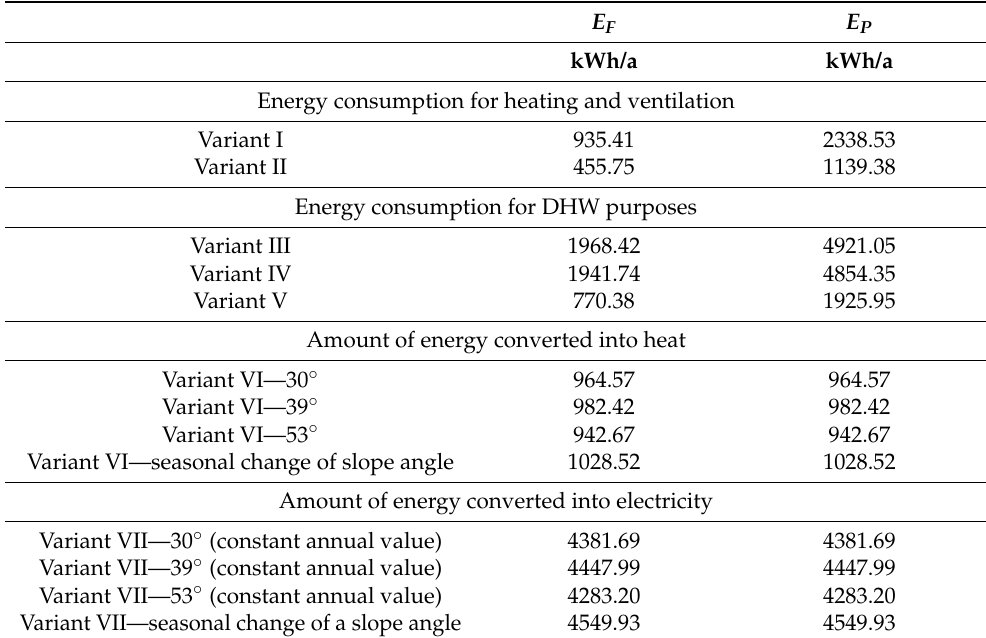
Table 2. The estimations of energy demands for variants I–V and the energy produced for variants VI and VII.